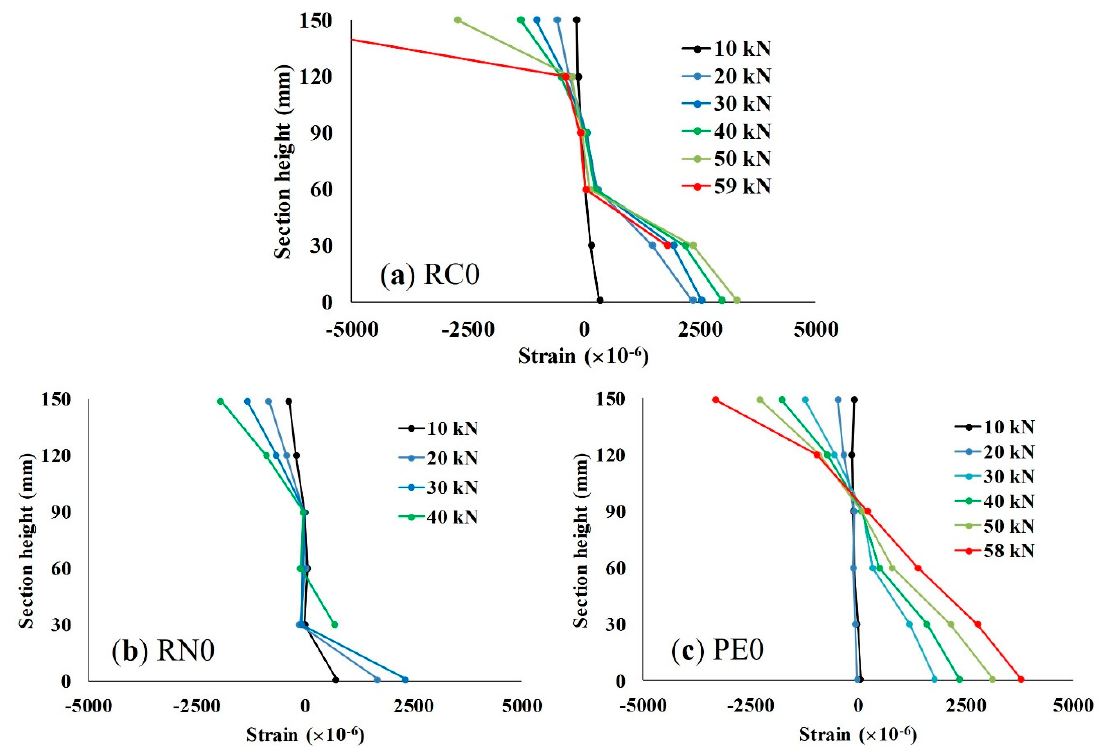
Figure 7. Strain distributions at the midspan of group A beams: ( a ) RC0; ( b ) RN0; and ( c ) PE0.